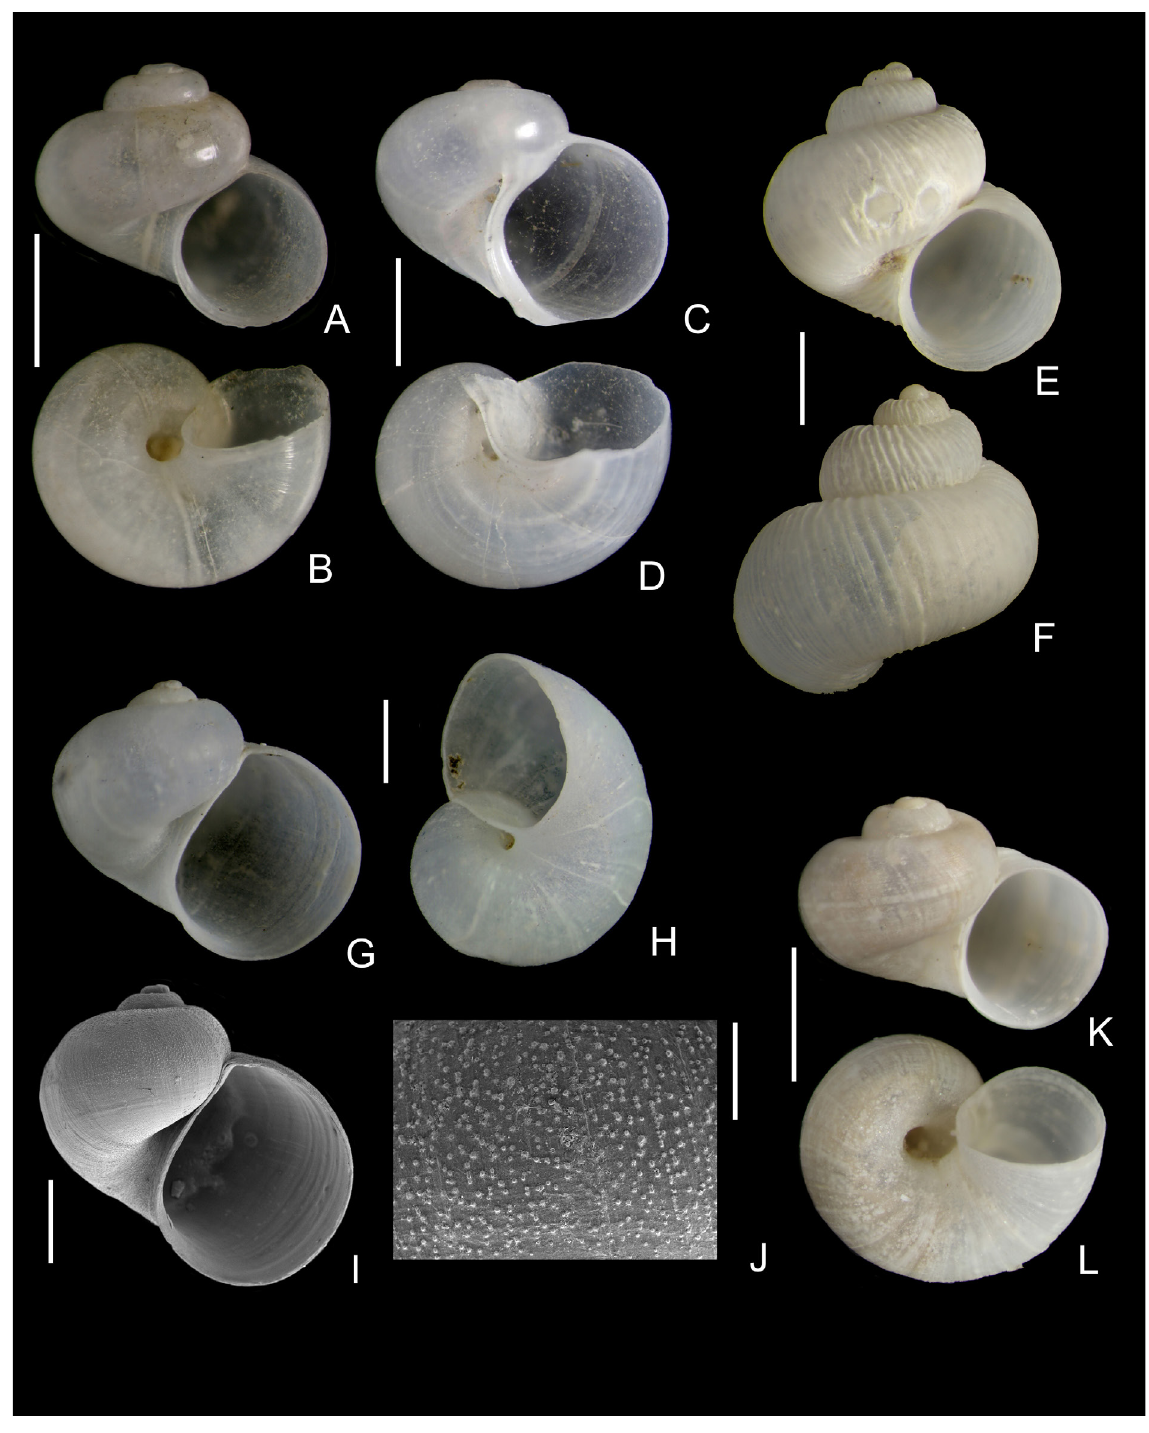
Fig. 15. Skeneimorph species 2. A–B . Akritogyra similis (Jeffreys, 1883), BANGAL 0711, V5, 1631 m, diameter 2.2 mm. C–D . Moelleriopsis sp., SEAMOUNT 1, DW108, 1120–1125 m, 2.7 mm. E–F . “ Skenea ” ponsonbyi (Dautzenberg & H. Fischer, 1896), BANGAL 0711, V9, 1671 m, 3.2 mm. G–H . Granigyra pruinosa (Jeffreys, 1883), BANGAL 0711, V10, 1720 m, 3.7 mm. I–J . SEM micrograph, same shell, and detail of microsculpture. K–L . Granigyra tenera (Jeffreys, 1883), BANGAL 0711, V10, 1720 m, 2.3 mm. Scale bars: A–I, K–L = 1 mm; J = 200